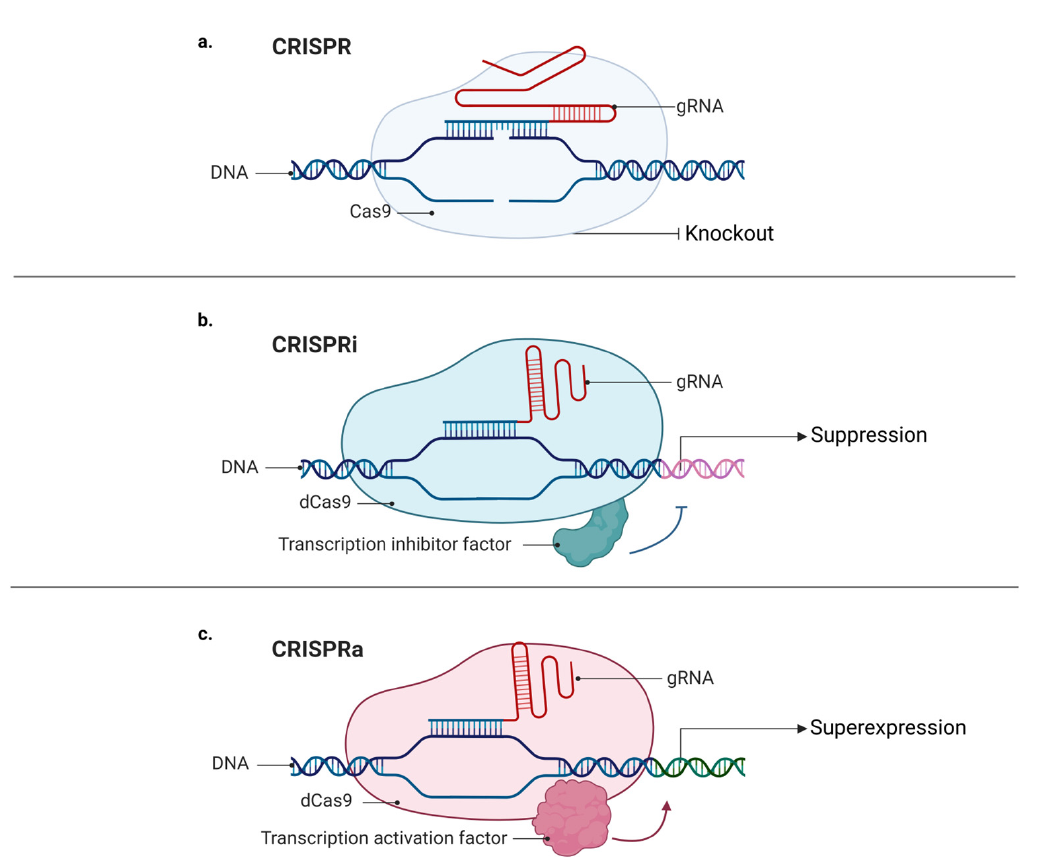
Figure 3. Mechanisms of CRISPR, CRISPRa, and CRISPRi: ( a ) classic CRISPR mechanism compris- ing a guide RNA (gRNA), target DNA, and endonuclease (Cas9), which promotes DNA cleavage, resulting in a knockout; ( b ) CRISPR mechanism comprising a guide RNA (gRNA), sequence target (target DNA), and “dead” endonuclease (dCas9), without its catalytic domain, fused with inhibitory transcription factors favoring decreased expression and generating knockdown; ( c ) CRISPR mech- anism comprising a guide RNA (gRNA), target sequence (target DNA), and “dead” endonuclease (dCas9), without its catalytic domain, fused with transcriptional activating factors, favoring increased expression and causing upregulation of a given gene.